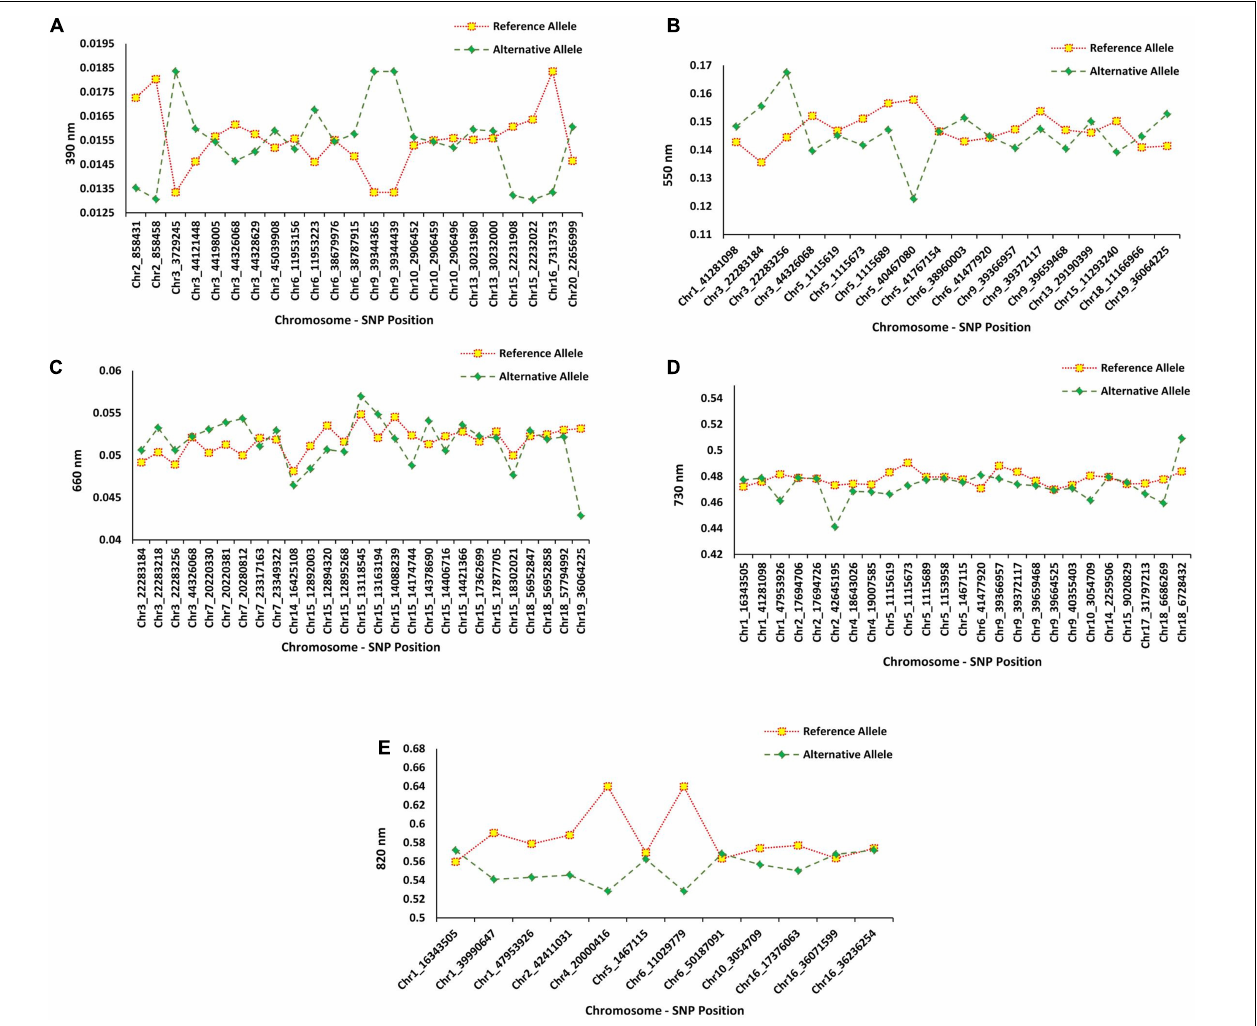
FIGURE 9 | The average effects of reference allele and alternative allele from the detected SNP’s peak for (A) 390 nm, (B) 550 nm, (C) 660 nm, (D) 730 nm, and (E) 820 nm in 227 soybean genotypes across four